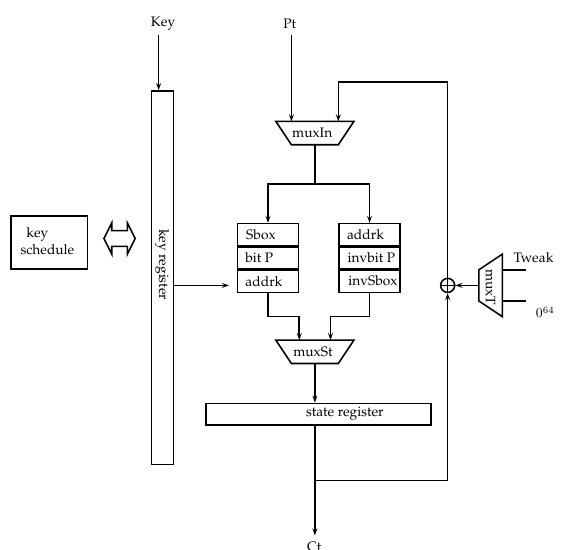
Figure 7: Architecture of TweGIFT-64 Implementation